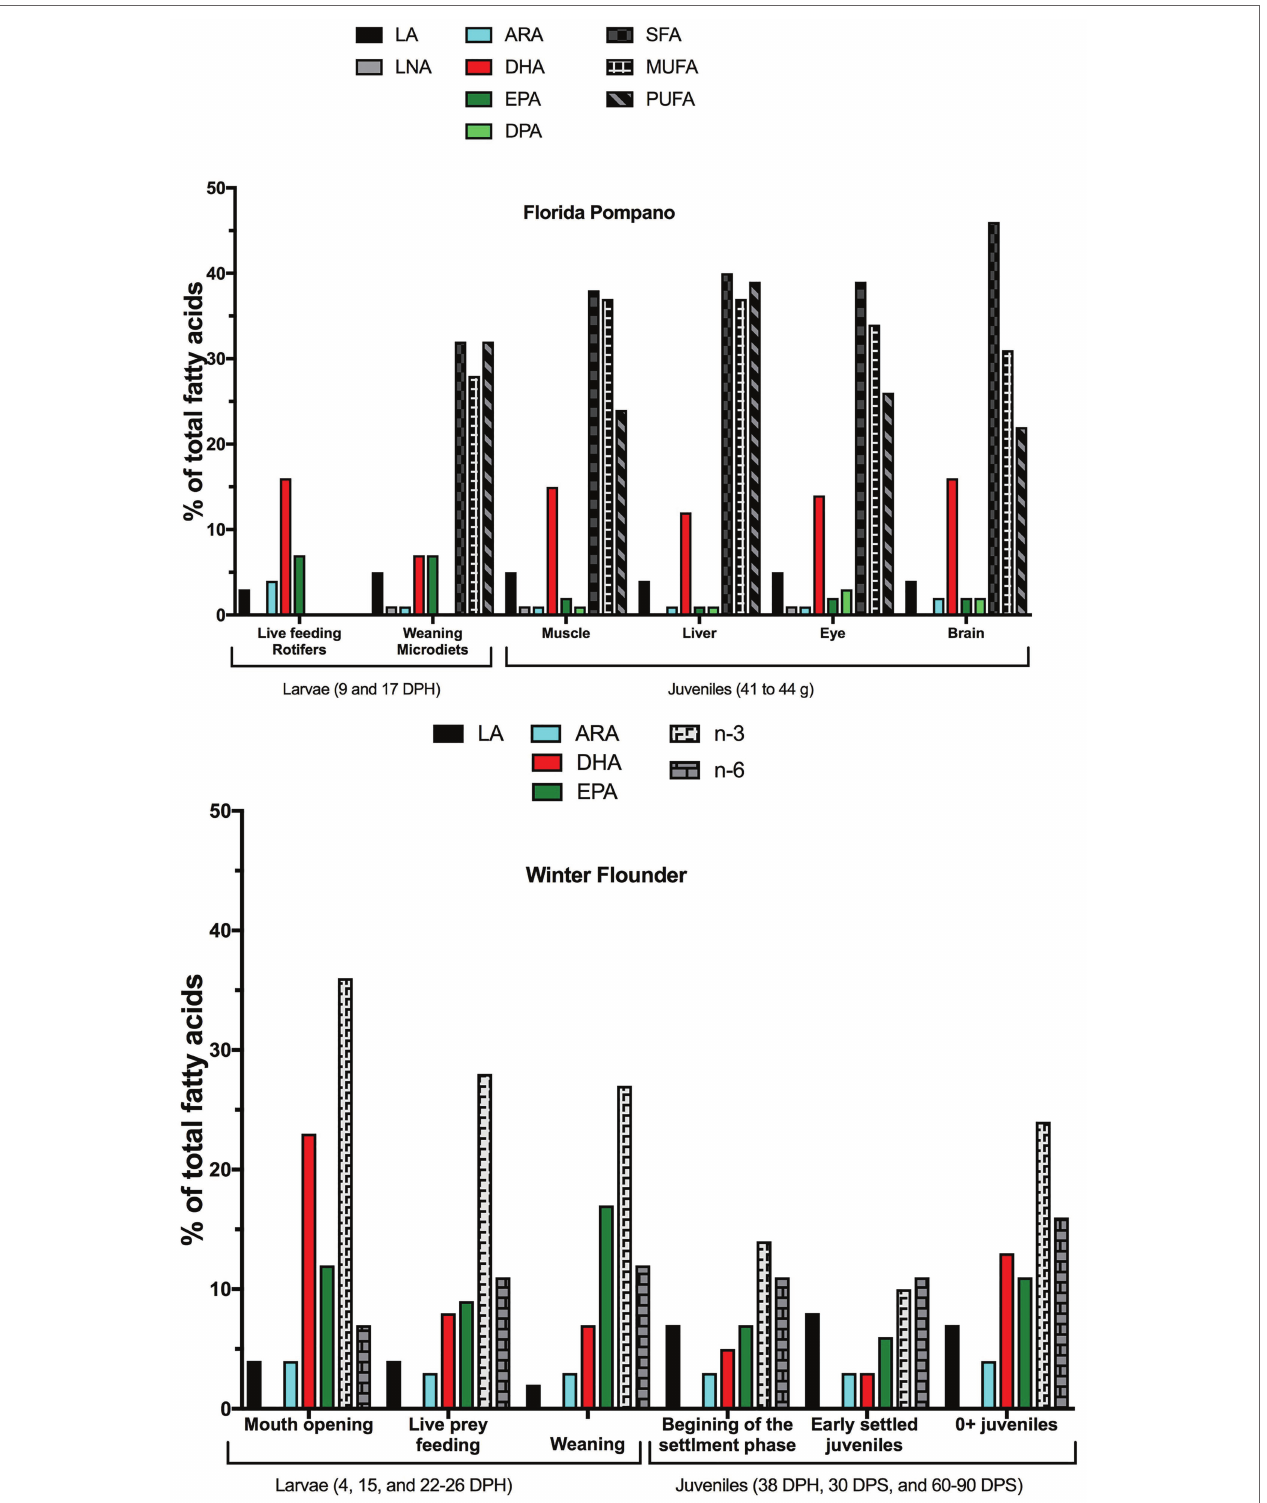
FIGURE 6 | Optimum relative percentages of essential fatty acids (EFA) in Florida pompano ( T. carolinus ) larvae and juveniles (top) and winter flounder ( P. americanus ) larvae and juveniles (bottom). We determined the optimum qualitative requirements (percentages) from data that had larva to diet or juvenile to diet ratios closest to one. DPH, days post hatch; DPS, days post settlement; LA, linoleic acid; LNA, linolenic acid; ARA, arachidonic acid; DHA, docosahexaenoic acid; EPA, eicosapentaenoic acid; SFA, saturated fatty acids; MUFA, monounsaturated fatty acids; and PUFA, polyunsaturated fatty